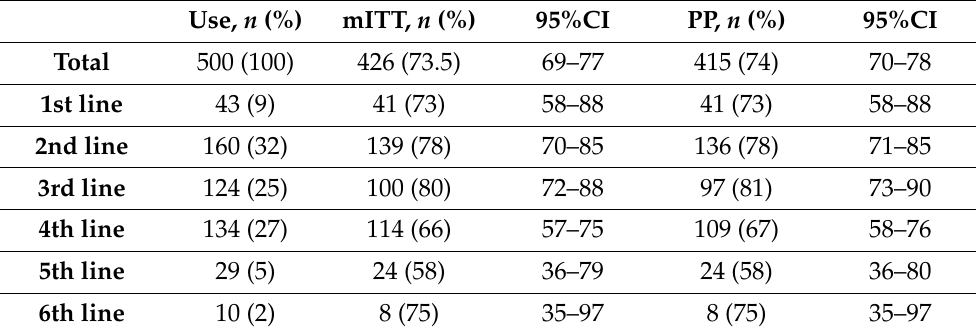
Table 2. Rifabutin-containing prescriptions and overall effectiveness according to treatment